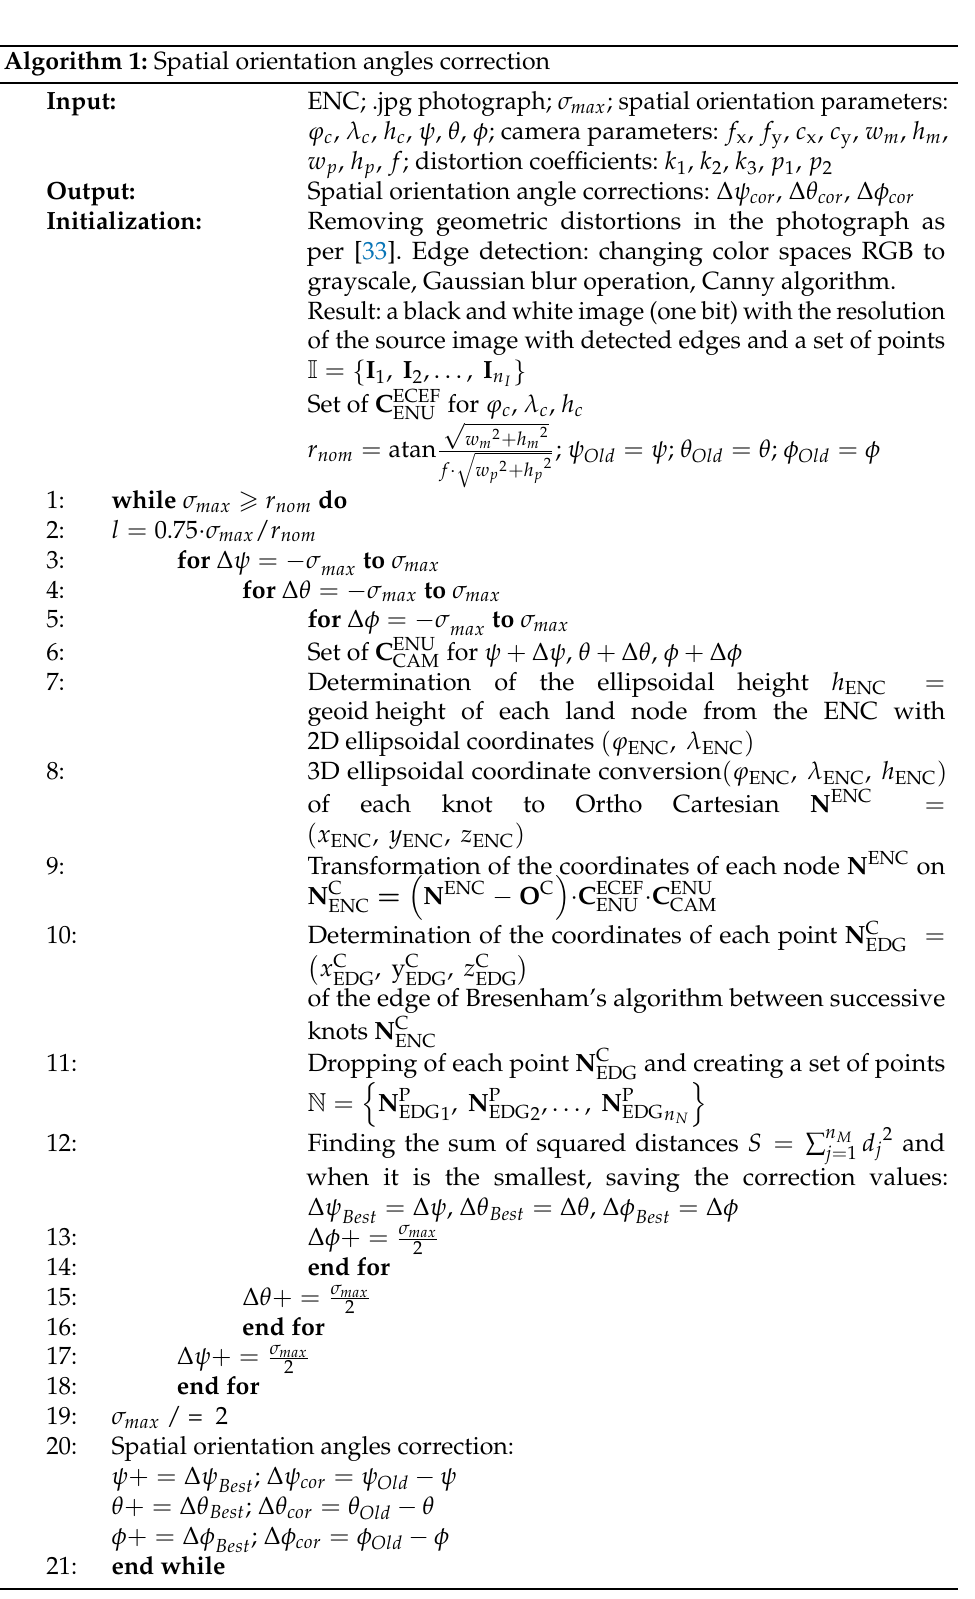
Algorithm 1: Spatial orientation angles